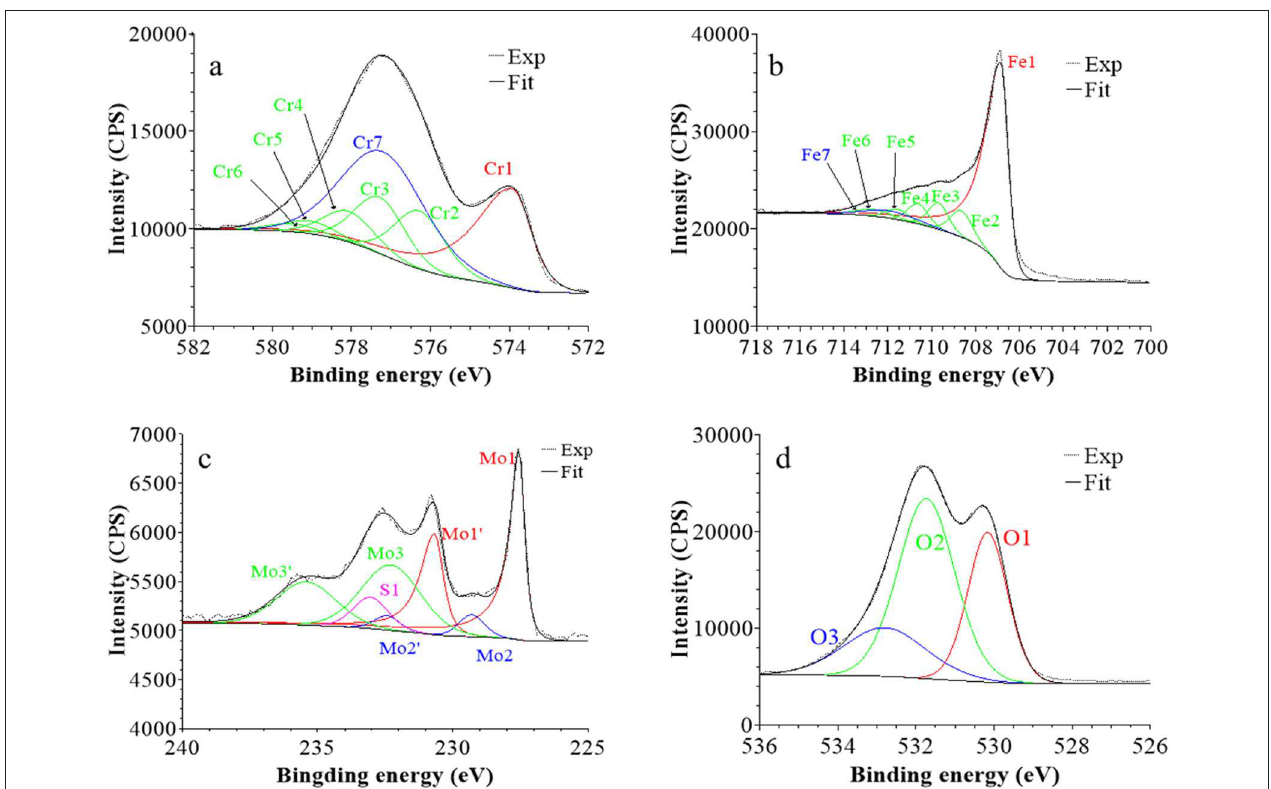
FIGURE 6 | XPS core level spectra and their reconstruction for 316L SS immersed in 0.05M H 2 SO 4 at U OCP for 30 min: (a) Cr 2p 3 / 2, (b) Fe 2p 3 / 2, (c) Mo 3d 5 / 2 − 3 / 2 , and (d) O 1s regions (take-off angle: 90 ◦